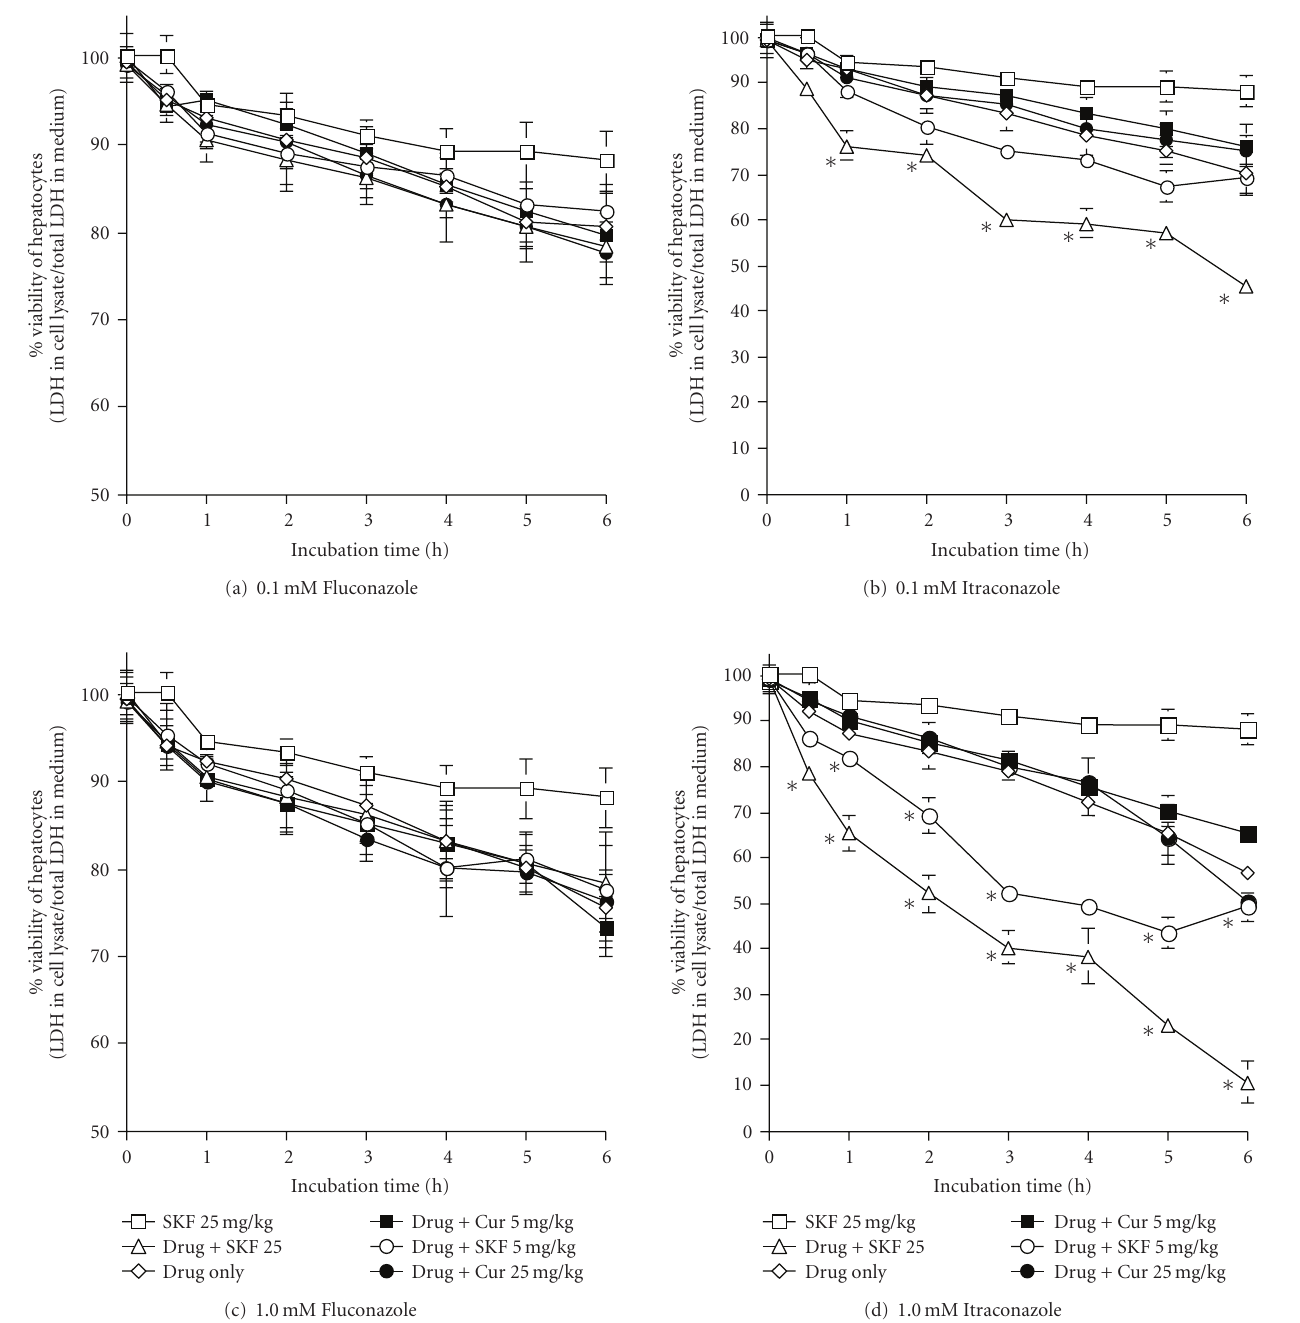
Figure 3: E ff ects of Cytochrome P450 inhibitors on the viability of hepatocytes treated with fluconazole or itraconazole. Values are mean ± sd of 3 separate experiments. ∗ Significant di ff erent ( P < . 05) when compared to controls and drug only groups. Drug = itraconazole or fluconazole; Cur = curcumin; SKF = SKF